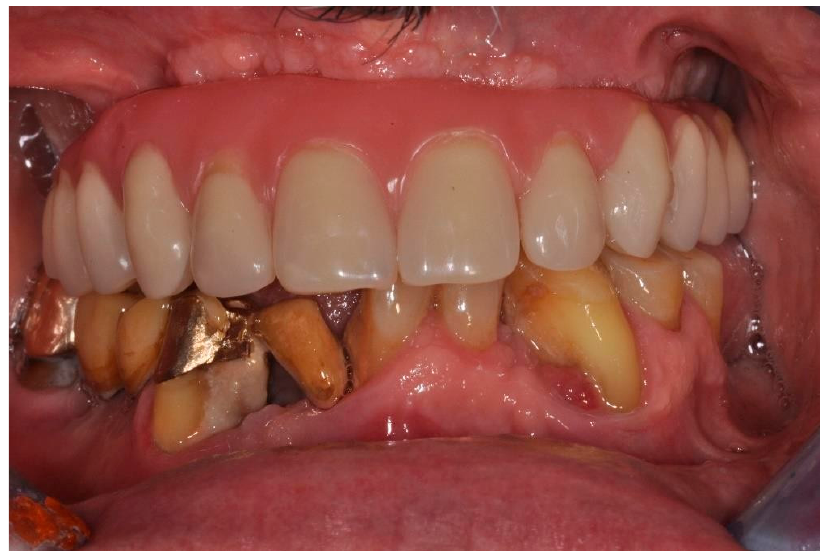
Figure 2. After jaw rehabilitation .